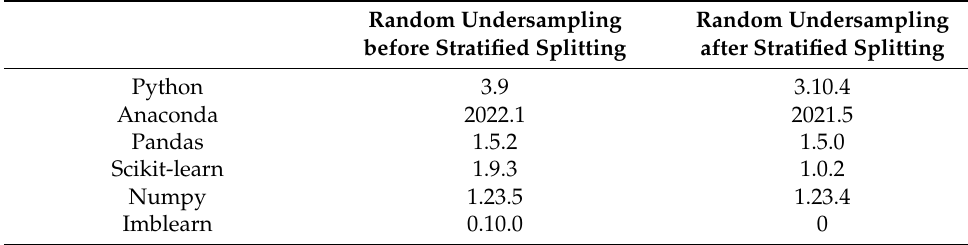
Table 4. Python library